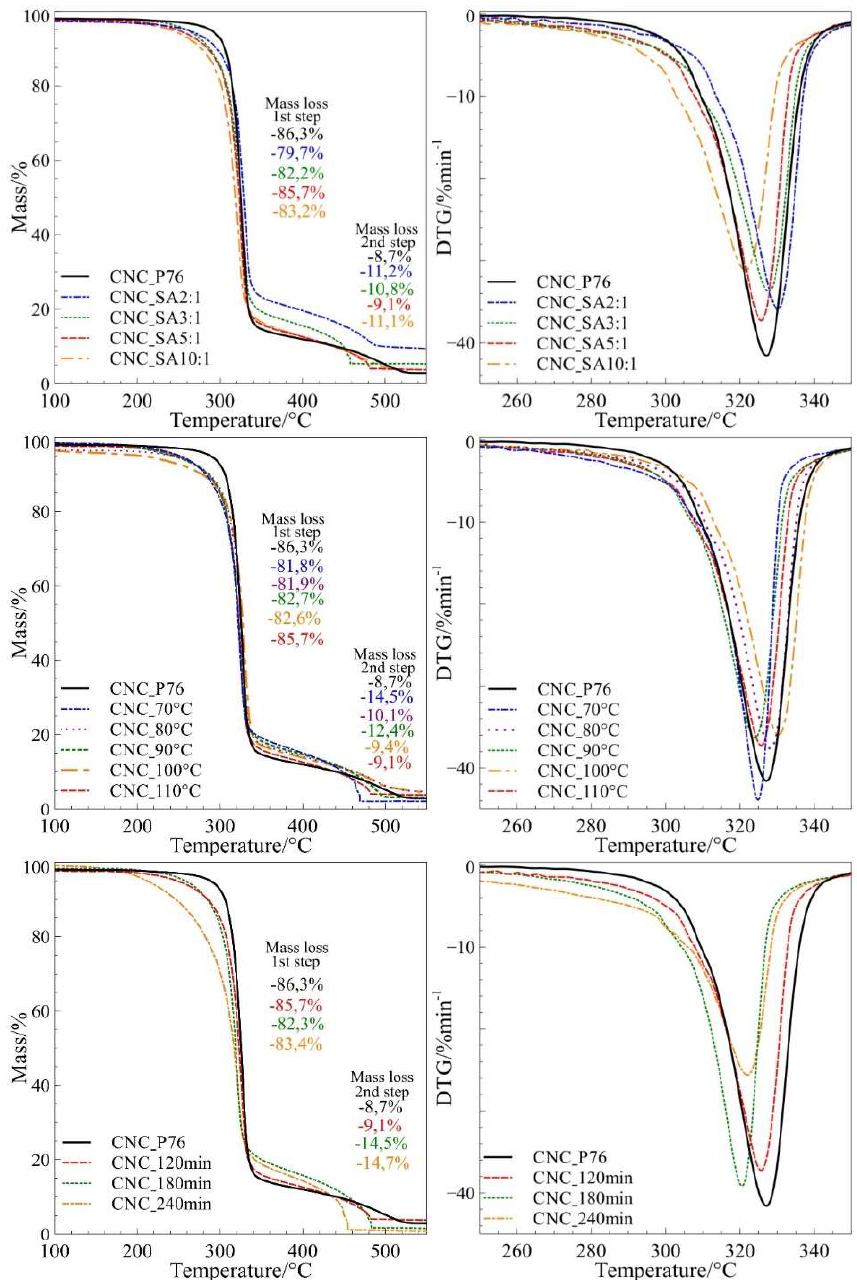
Figure 10. TG and DTG curves of modified cellulose nanocrystals during thermo-oxidative